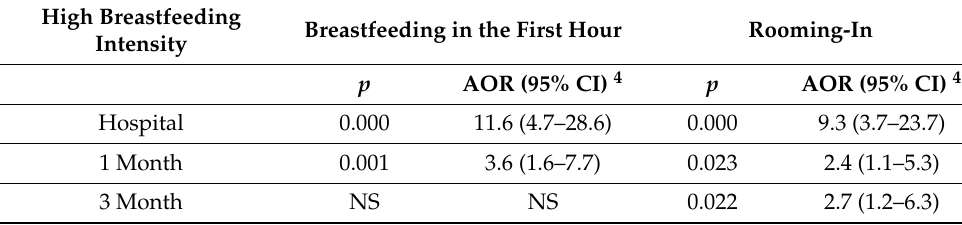
Table 3. Adjusted 1 Odds of Breastfeeding in First Hour and Rooming-In on High Breastfeeding Intensity 2,3